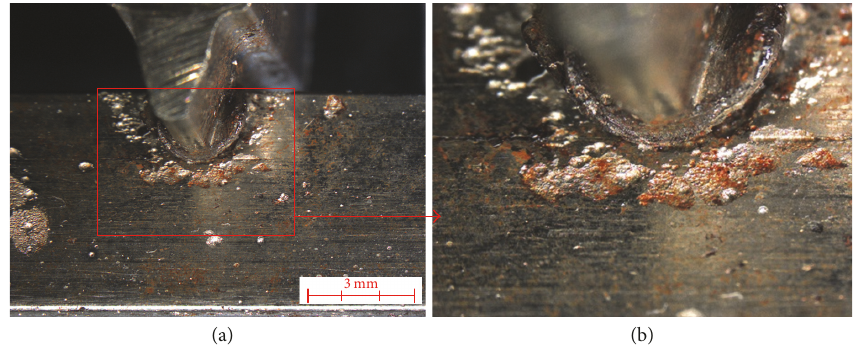
Figure 2: Resistance welding weldment corrosion (a) and magnified HAZ (b), stereoscopic microscope.